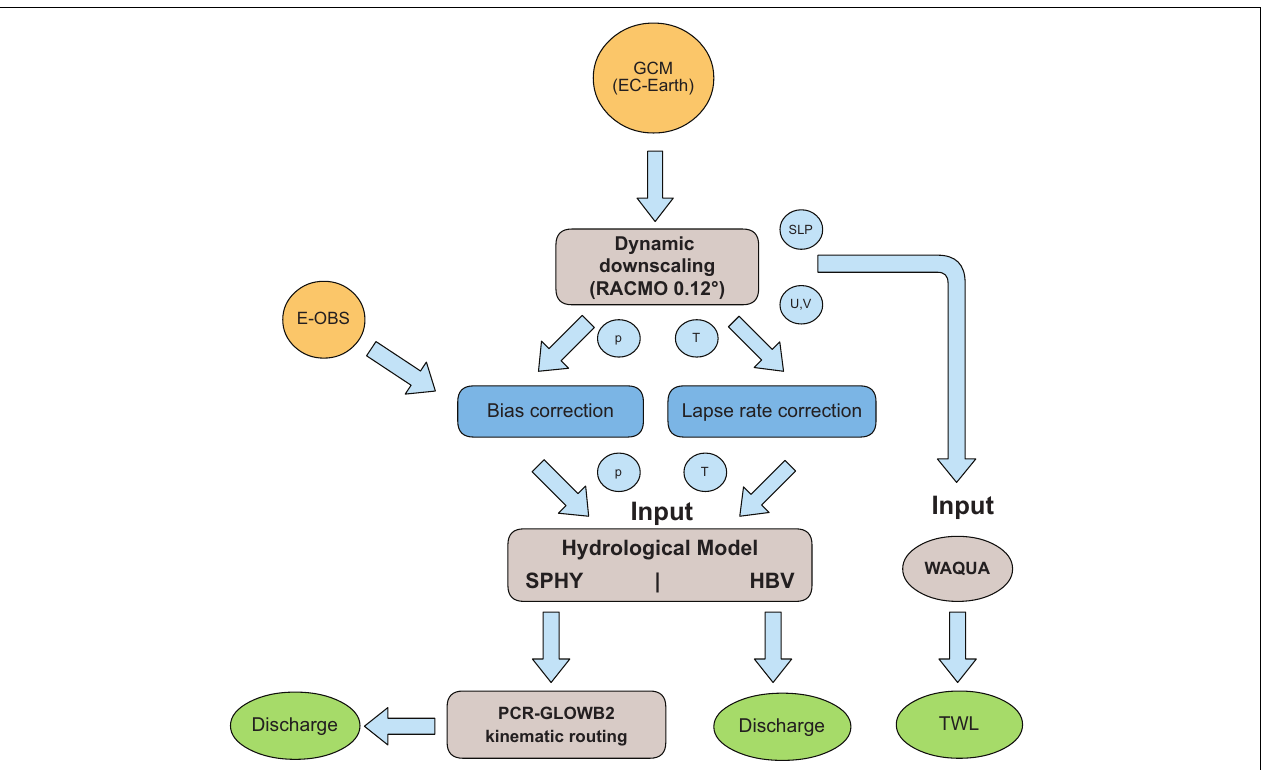
FIGURE 2 | The research framework used in this study. The orange, green and gray color represents the input, output and the model used in the study, respectively. The P, T, SLP, U and V represents the precipitation, temperature, sea level pressure, zonal and meridional wind components, respectively. The blue color represents the intermediate steps followed like bias correction of precipitation and lapse rate correction of temperature obtained from downscaling EC-Earth.